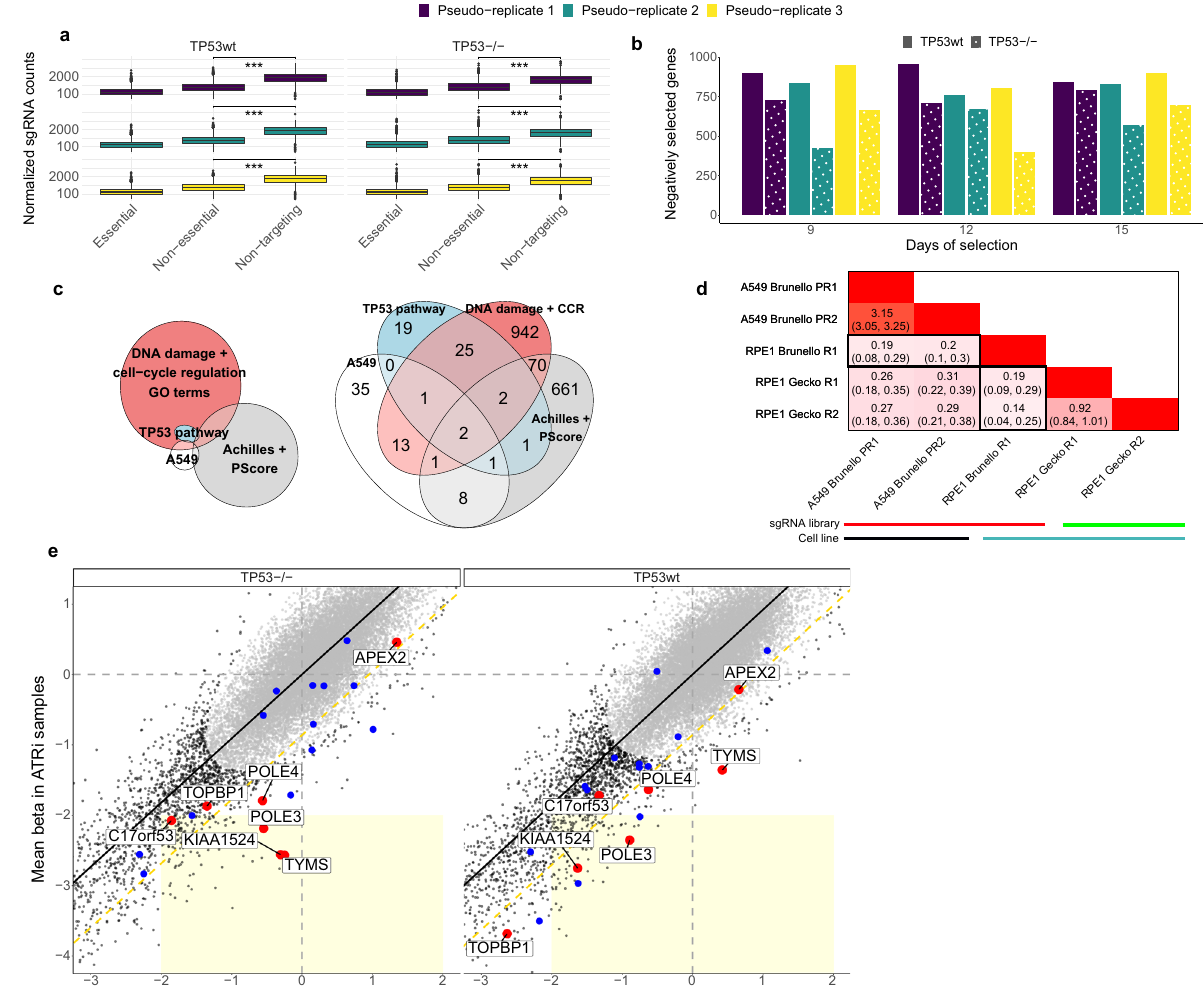
Fig. 1 | A TP53 wild-type backgroundcanconfound estimatesofgene selection in genetic screens. a Boxplots showing the pooled normalized sgRNA counts per sample (essential and non-essential genes, and non-targeting sgRNAs; 15 day samples are shown). Tested using 1-tailed Mann-Whitney. *** denotes a p <2.2e-16. No adjustments were made for multiple comparisons. n =7300 independent sgRNAs examined over six independent experiments. b Barplot showing the number of genes that are negatively (beta score<0) selected, per sample used in this study. Beta score signi fi cance: FDR<0.25. c Venn (left) and corresponding Euler (right) diagrams of the overlap of genes between four sets: genes negatively selected exclusively in TP53wt in our samples (A549), genes negatively selected exclusively in TP53wt in Project Achilles and Score (Achilles + Score), top-50 TP53- interactors (TP53 pathway), and genes included in 19 GO terms related to DNA damageandcell-cycleregulationthatwefoundenrichedwithgenesfromtheA549 set. d Results of the analysis of overlap between different cell lines and/or sgRNA libraries detailed in Supplementary Text 1a: heatmap shows the log 2 odds ratio of the overlap of genes negatively selected exclusively in TP53wt, between different